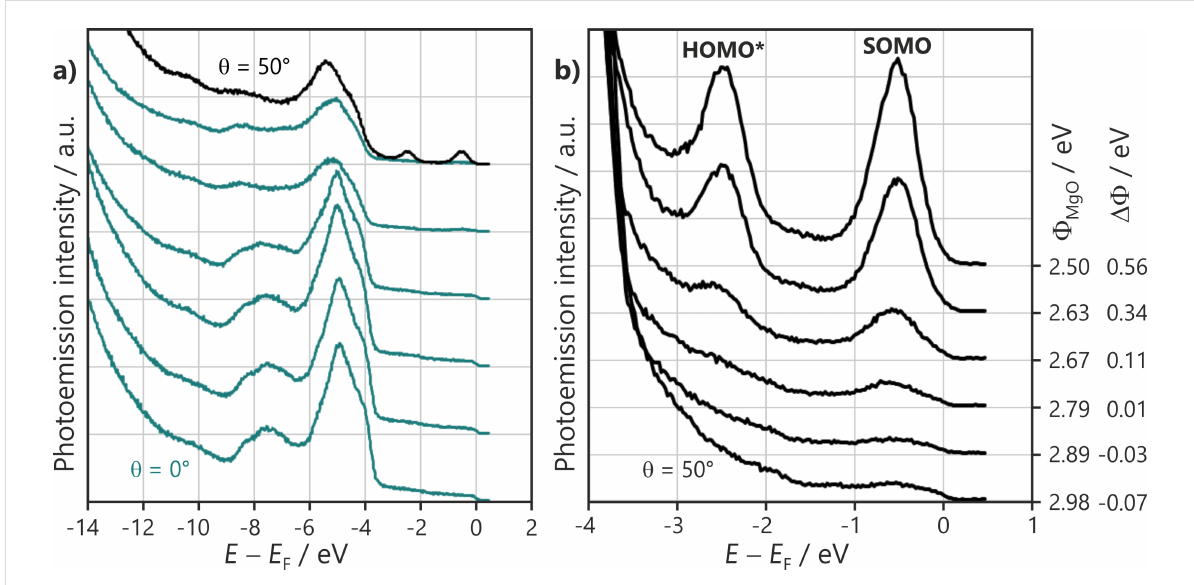
Figure 4: He I ARUPS spectra for different preparations with the same saturation exposure of 6P (4 Å) on the same 2 ML MgO film tuned to different work functions. Φ MgO values and the change in Φ induced on 6P exposure ( ΔΦ ) are given on the right. (a) Wide scans at normal emission ( θ = 0°) emphasizing the MgO emission region. The black curve shows the ARUPS spectrum measured at θ = 50° in the [001] azimuth, where the 6P HOMO* and SOMO emissions in the MgO bandgap region are prominent. (b) Magnification of the HOMO* and SOMO emissions in the MgO bandgap at θ =